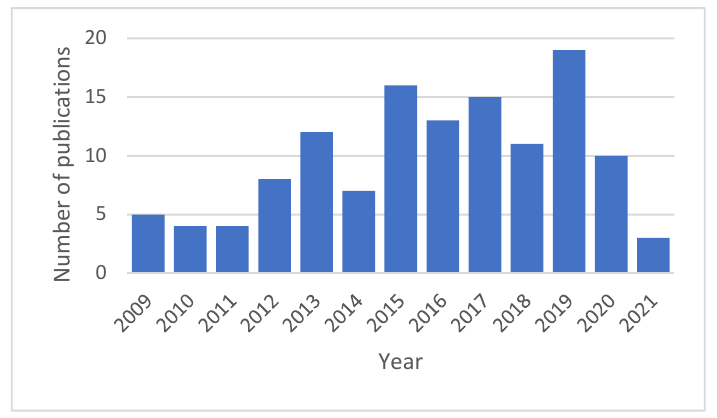
Figure 5. Number of publications per year.